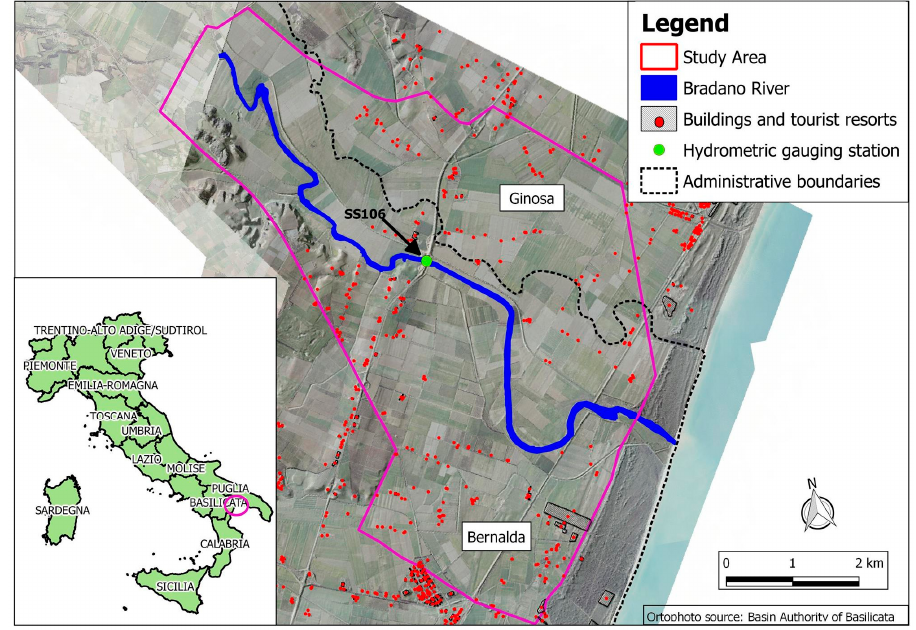
Figure 1. The Bradano River mouth case study. Table 1. Characteristics of the Cosmo-SkyMed (CSK) observations provided by the Italian Space Agency (ASI).